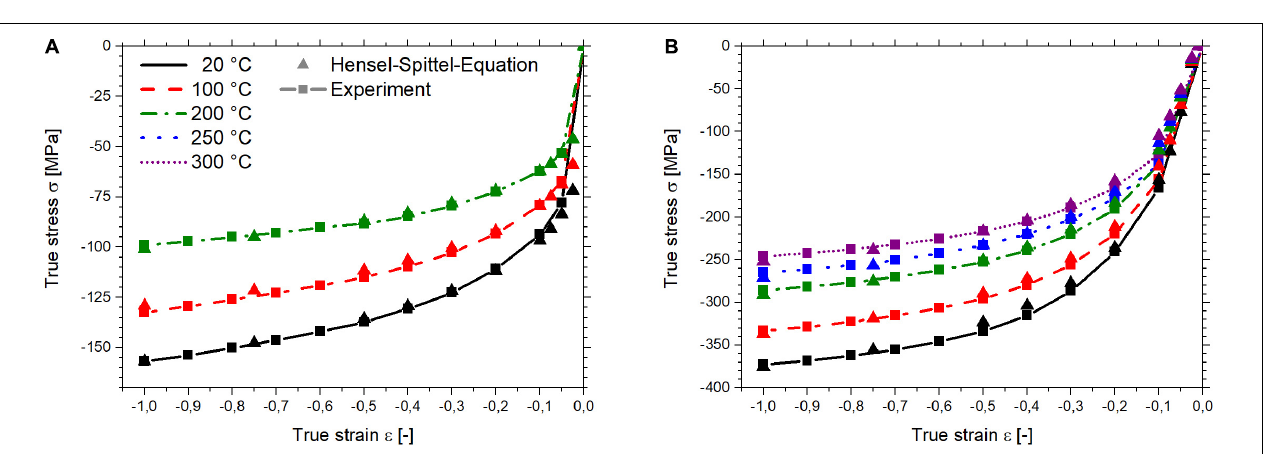
FIGURE 5 | Illustrations of cross sections 1 and 1C: (A) scan of cross section 1, (B) digital processed scan of cross section 1, (C) scan of cross section 1C, (D) digital processed scan of cross section 1C; (E) correlation of extrusion force and development of the equivalent copper cross section.